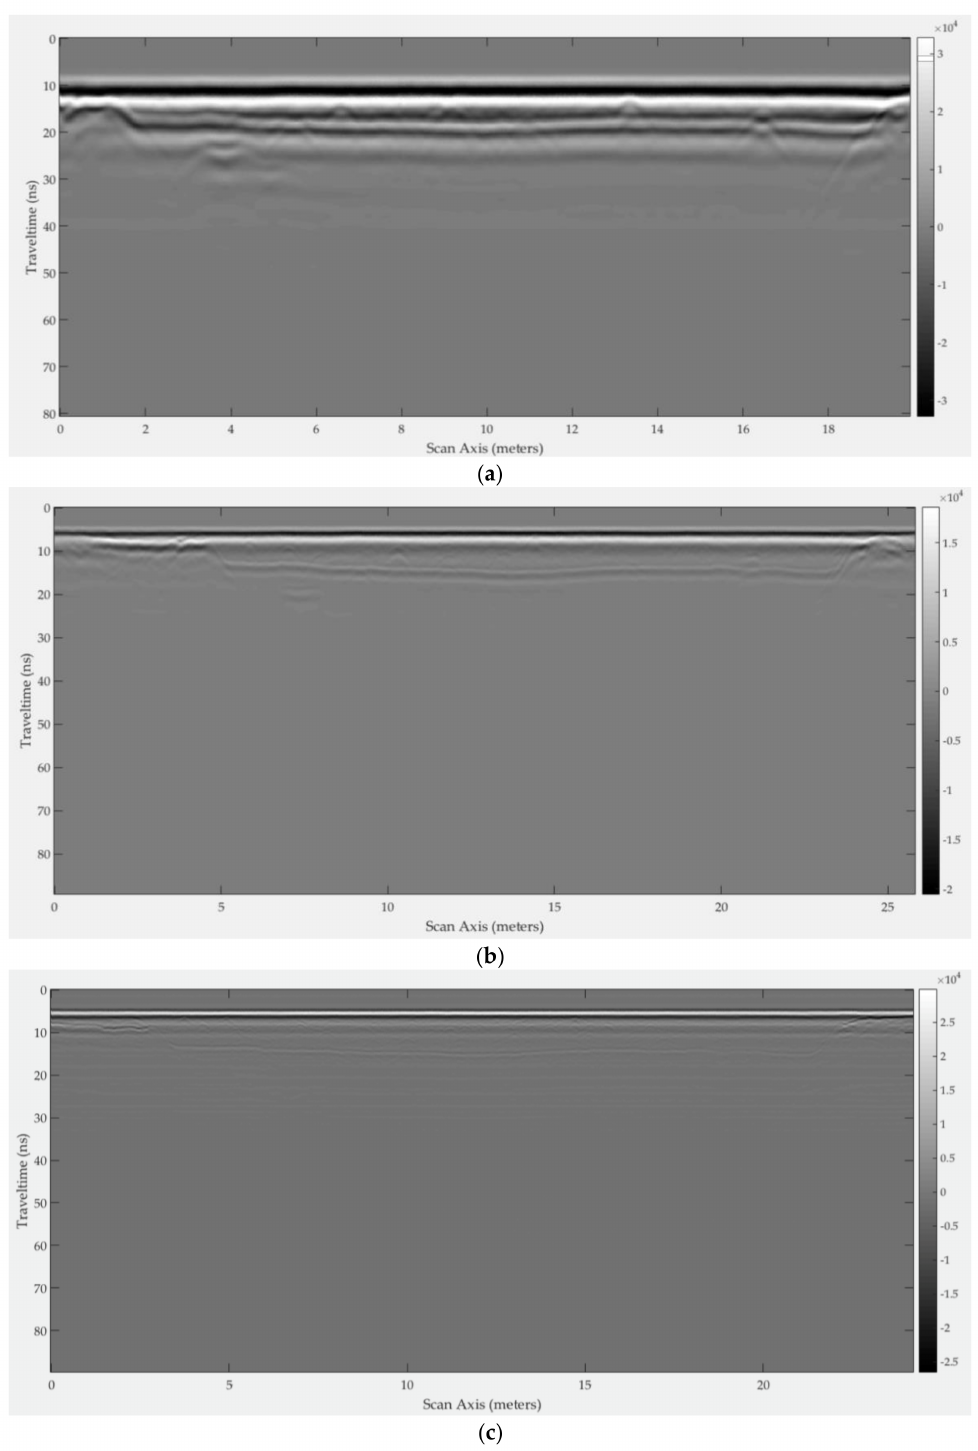
Figure 17. Profiles recorded in the silt region by using GPR 2, on acquisition line 1, with antennas operating at: ( a ) 250 MHz; ( b ) 500 MHz; ( c ) 800